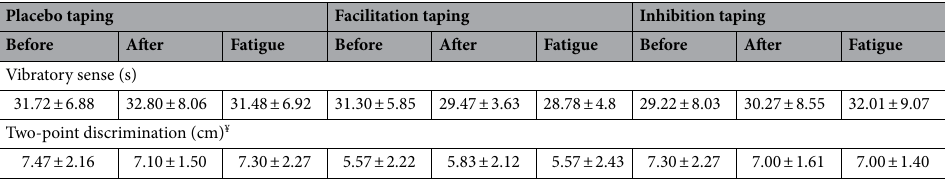
Table 5. Superficial sensory test results of three taping groups. ¥ Significant difference between facilitation taping and Placebo taping; between facilitation taping and Inhibition taping.